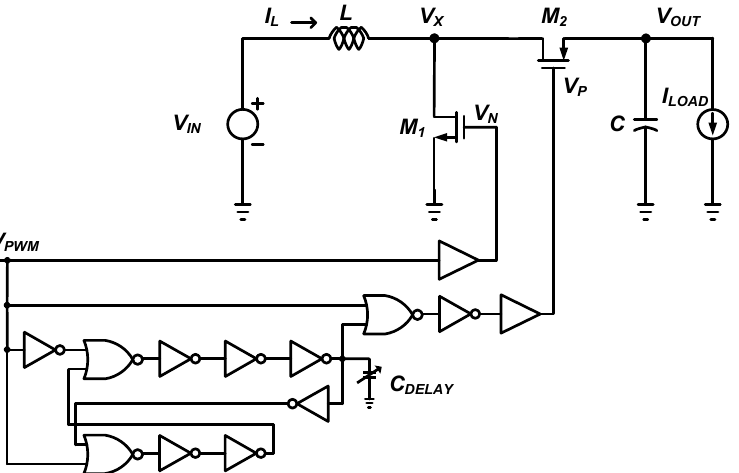
Figure 7. Schematic of the DC-DC boost converter with the control circuits.